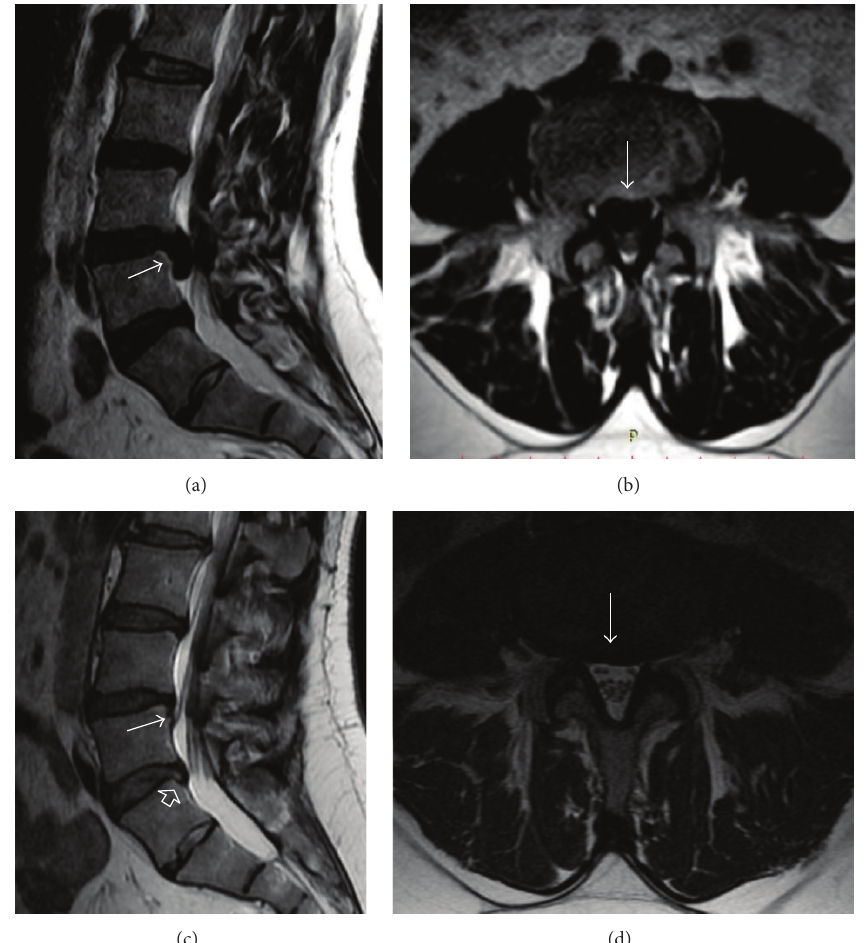
Figure 2: (a) A huge extruded disc herniation that migrated caudally (white arrow) at L4-5 level on T2 weighted sagittal lumbar MR images. (b) Axial view of the same disc, extruded disc occupying nearly half of the spinal canal. (c and d) The extruded disc has disappeared completely (white arrows) in sagittal and axial MR images after three years; the height of the disc space slightly decreased at L4-5 level and there was no sign of compression. The protrusion of L5-S1 disc (arrow head) that will be obvious in the left sagittal images.